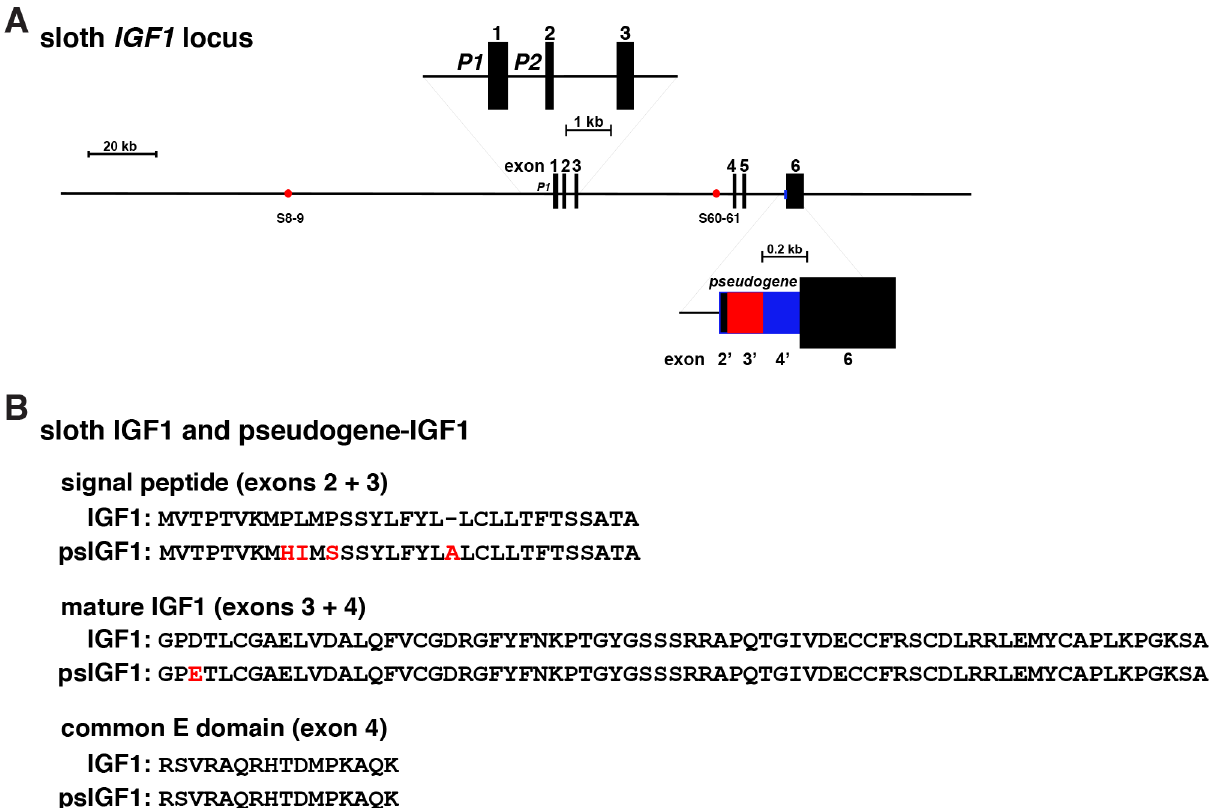
Fig 9. The sloth IGF1 locus encodes a processedpseudogene. A . Map of the sloth IGF1 gene and locus. Exons are depicted as boxes, and introns and flankingDNA as horizontal lines. The enlargement above the main map illustrates the two Igf1 promoters, P1 and P2, and exons 1–3. Red circles represent locationsof homologues of sites shownto bind Stat5b in a GH-inducible way in the rat Igf1 locus. The enlargementbelowthe main map depicts the locationand structure of the putative IGF1 pseudogene, which consists of DNA segments that are nearlyidenticalto sloth IGF1 exons 2, 3, and 4 (color codedin black, red, and blue, and marked as exons 2’, 3’, and 4’, respectively). B . Comparisonof amino acid sequencesof sloth IGF1 with sloth pseudogene-IGF1 in single letter code. Differencesare depictedin red; a dash indicates no